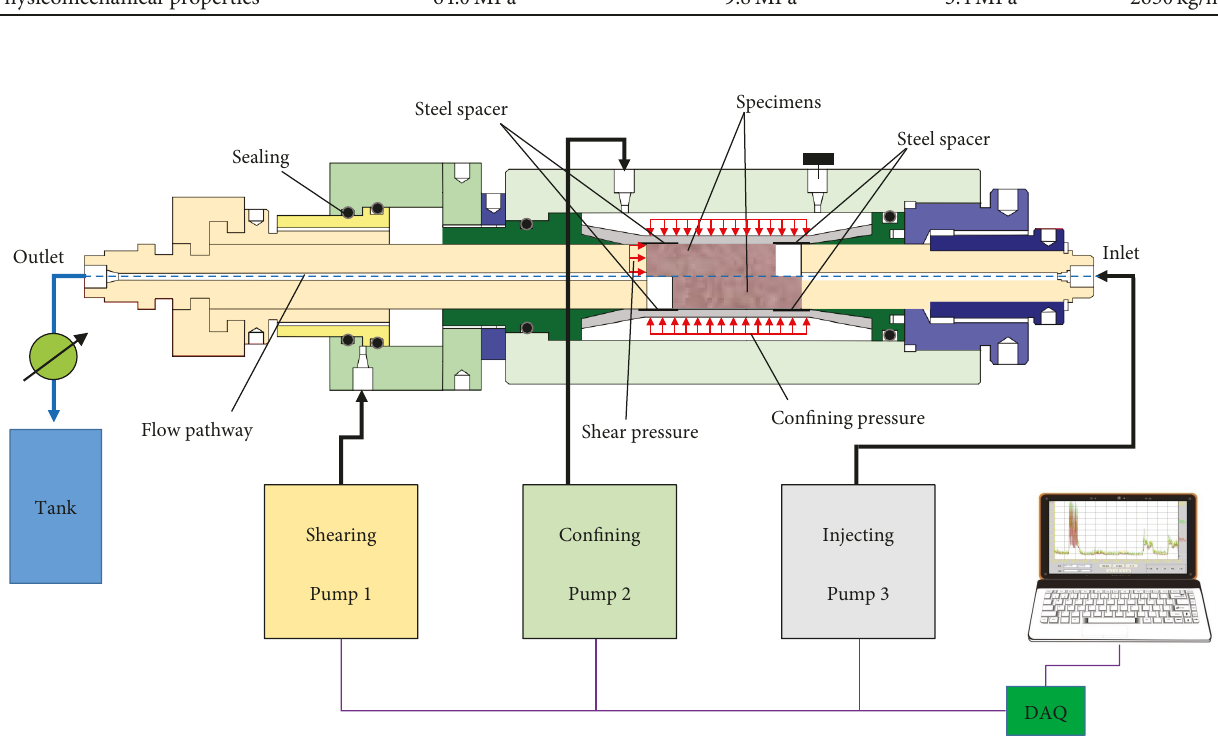
Figure 2: Shear-permeability test